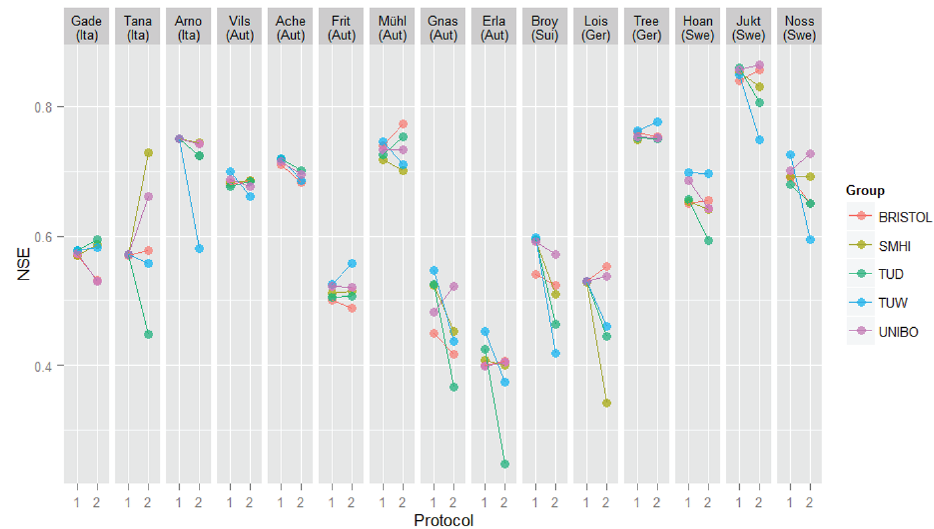
Figure 4. Nash–Sutcliffe efficiency (NSE) estimated for model validation, obtained by the five research groups, for the 15 catchments, according to Protocols 1 and